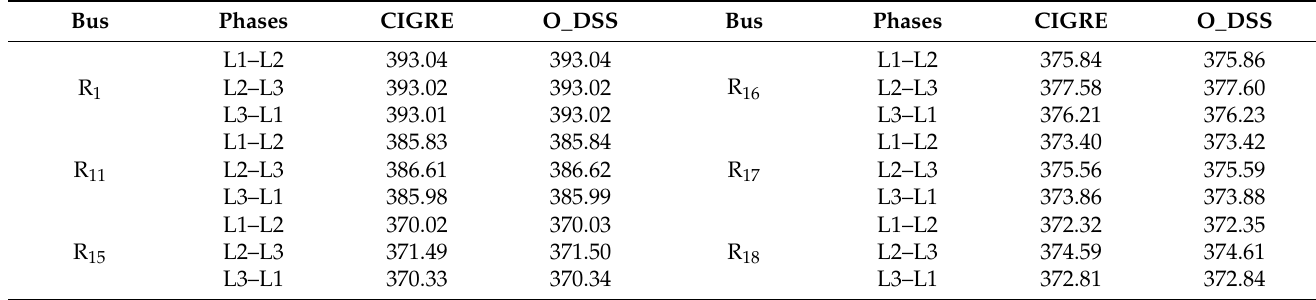
Table 3. Phase-to-phase voltages (V) for load buses in the CIGRE test network.